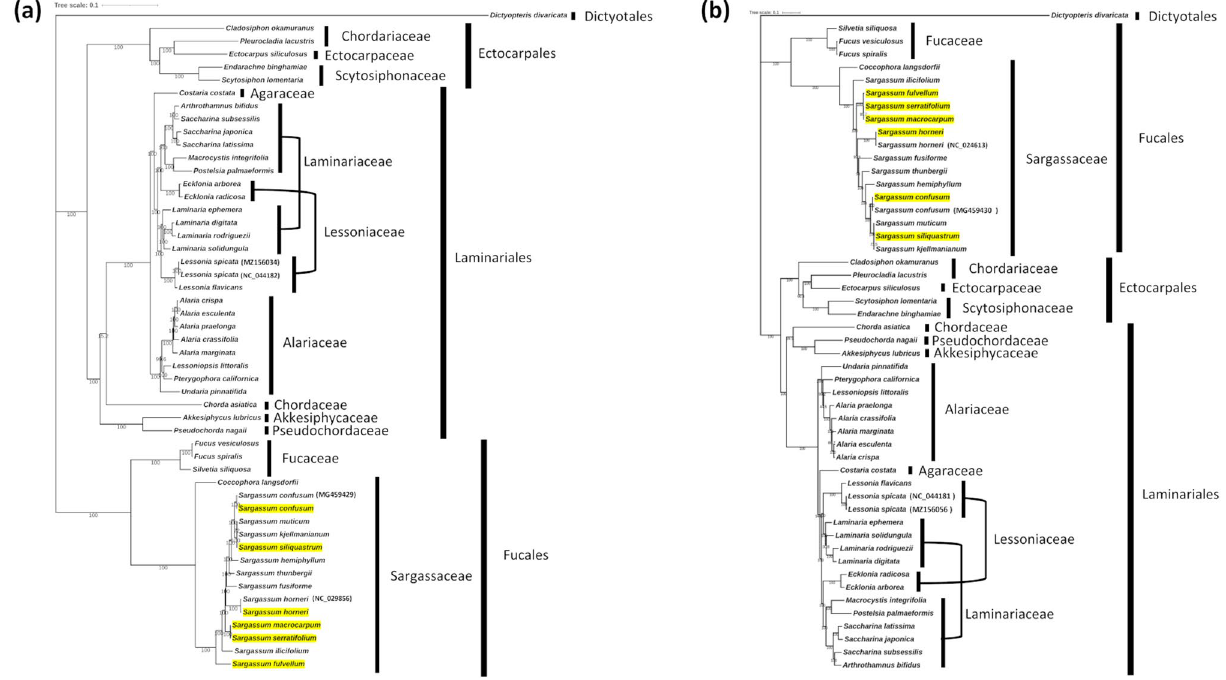
Figure 6. Phylogenetic analysis of 50 Phaeophyceae species including the 44 species deposited in NCBI and the six newly sequenced Sargassum genomes using Maximum Likelihood (ML) methods based on the concatenated shared PCG sequences of ( a ) chloroplast and ( b ) mitochondria. Yellow colored species are newly sequenced species. The numbers at internal nodes indicated maximum likelihood (ML) bootstrap